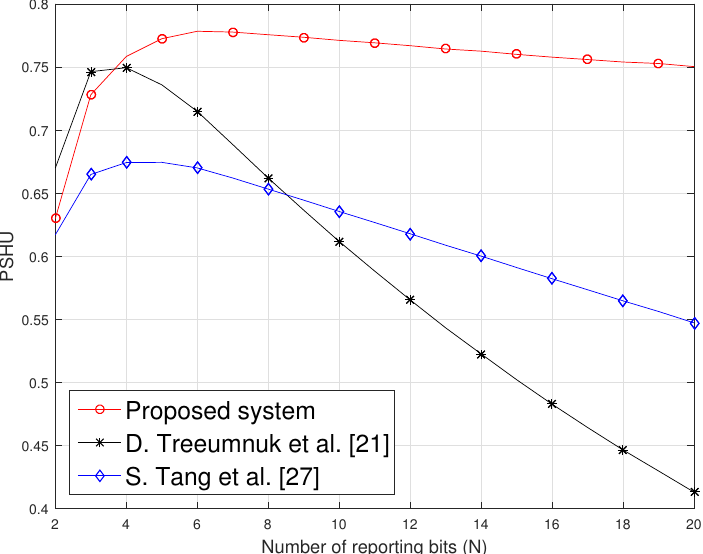
Figure 4. Probability of spectrum hole utilization (PSHU) vs. number of reporting bits (N)